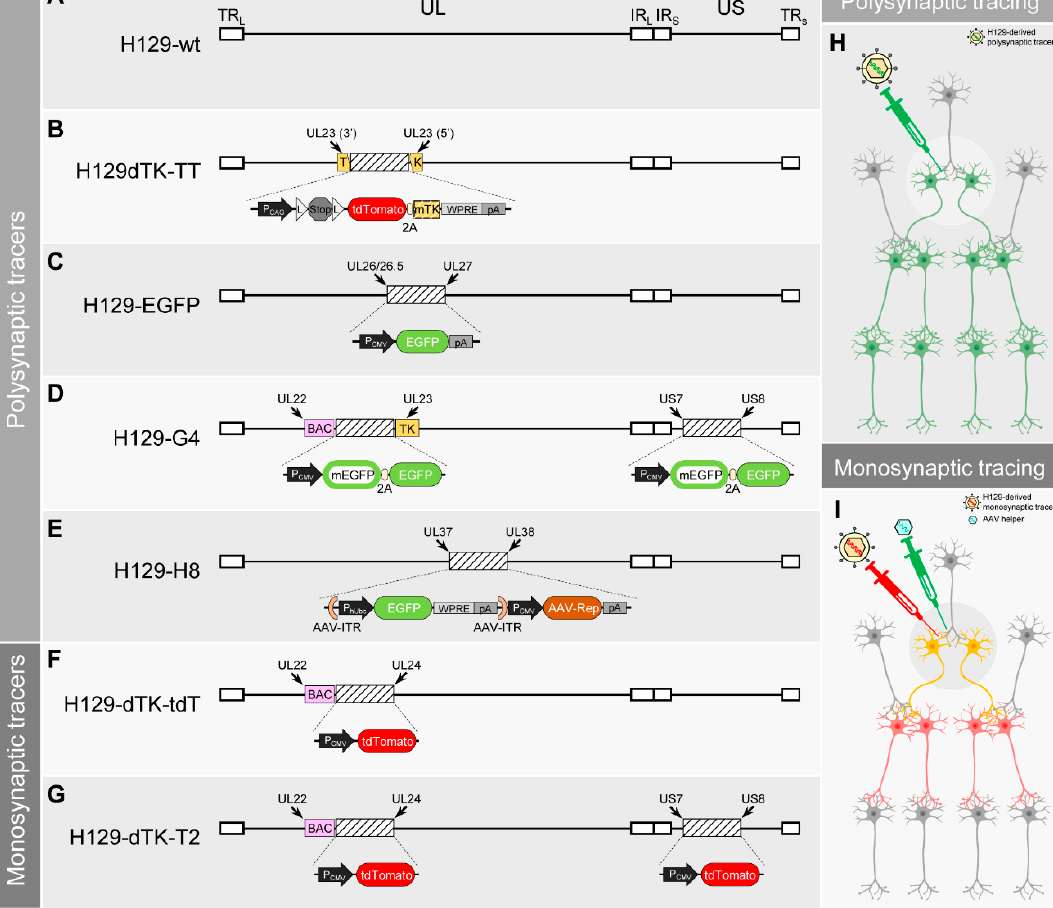
Figure 1. Genomes of current H129-derived tracers, and anterograde tracing schematics. ( A – E ). Genome schematics of current H129-derived polysynaptic tracers. ( A ) Wildtype H129 (H129-wt). The genome of HSV-1 strain H129 (H129) is composed of 2 regions, unique long (UL) and unique short (US), which are flanked by terminal repeat (TR) and internal repeat (IR), respectively. ( B ) H129dTK-TT. The coding gene of tdTomato and codon-modified TK ( mTK ) is linked by the sequence encoding 2A self-cleaving peptide (2A). A LoxP-Stop-LoxP element is placed between CAG promoter (P CAG ) and tdTomato-2A-TK cassette. WPRE is used as an enhancer, and poly(A) (pA) is used to stop the transcription. The whole expression cassette is inserted into the middle of the TK gene ( UL23 ) in the H129 genome. The original TK is knocked out by being split into 3 ′ - and 5 ′ - parts. ( C ) H129-EGFP. The EGFP expression cassette with CMV promoter (P CMV ) and poly(A) is inserted into the H129 genome between UL26 / 26.5 and UL27 . ( D ) H129-G4. The BAC sequence is inserted into the H129 genome between UL22 and UL23 to generate BAC-H129. The P CMV controlled binary-GFP expression cassette is composed of a membrane-bound EGFP (mEGFP) and an EGFP with a 2A linker. Two copies of the binary-GFP expression cassette are inserted into the H129 genome. One is placed between the BAC sequence and UL23 , and the other between US7 and US8 . ( E ) H129-H8. The GFP expression cassette is composed of EGFP controlled by human ubiquitin C gene promoter (P hUbc ) and WPRE-pA, which are all flanked by AAV2-ITR. The AAV replicase expression cassette is composed of the AAV2 Rep gene ( AAV-Rep ) and poly(A) (pA) controlled by P CMV . Both cassettes are inserted into the H129 genome between UL37 and UL38 . ( F – G ). Genome schematic of current H129-derived monosynaptic tracers. ( F ) H129-dTK-tdT. The tdTomato expression cassette driven by P CMV is inserted into BAC- H129 to replace the TK gene ( UL23 ), resulting in TK deletion. ( G ) H129-dTK-T2. Another identical tdTomato expression cassette (P CMV -tdT) is inserted into the genome of H129-dTK-tdT, between US7 and US8 . ( H – I ). Schematic diagram of polysynaptic and monosynaptic tracing. ( H ) Polysynaptic tracing. The H129 polysynaptic tracers (indicated by the enveloped virion with green genome) are